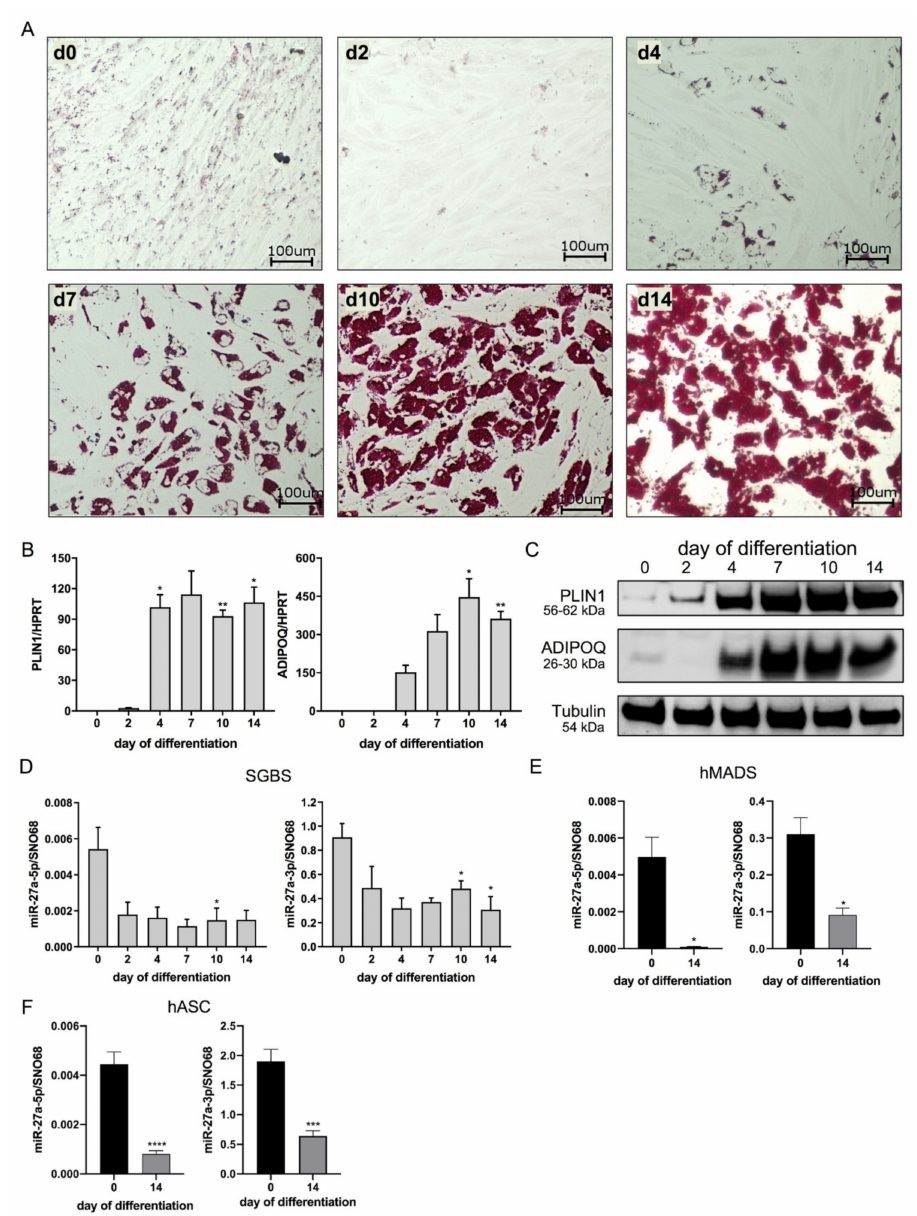
Figure 1. miR-27a-5p and -3p expression decreases during adipogenesis. To assess the expression of miR-27a-5p and -3p during adipogenesis, Simpson–Golabi–Behmel syndrome (SGBS) cells, human multipotent adipose-derived stem cells (hMADS) cells and adipose-derived stromal cells (hASCs) were subjected to adipogenic differentiation. SGBS cells were analyzed on days (d) 0, 2, 4, 7, 10 and 14; hMADS and hASCs, on day 0 and day 14. ( A ) Micrographs of SGBS cells stained with Oil Red O at indicated time points. Lipid droplets are stained in red. ( B ) mRNA expression of adipogenic factors as quantified by qPCR and normalized to HPRT. ( C ) One representative Western blot out of four independent experiments for the adipogenic markers PLIN1 and ADIPOQ with tubulin as loading control. Expression level of miR-27a-5p and -3p in ( D ) SGBS cells, ( E ) hMADS cells and ( F ) hASCs, as quantified by qPCR in relation to SNO68. Statistics: results are displayed as means and SEMs of 4 ( B , D , E ) and 9 ( F ) independent experiments. One-way ANOVA with Dunnett’s correction ( B , D ) and t -tests ( E , F ) for comparison with day 0; * p < 0.05; ** p < 0.01; *** p < 0.001; **** p < 0.0001. SNO68: SNORD68. HPRT: hypoxanthine-guanine phosphoribosyltransferase; PLIN1: perilipin; ADIPOQ: